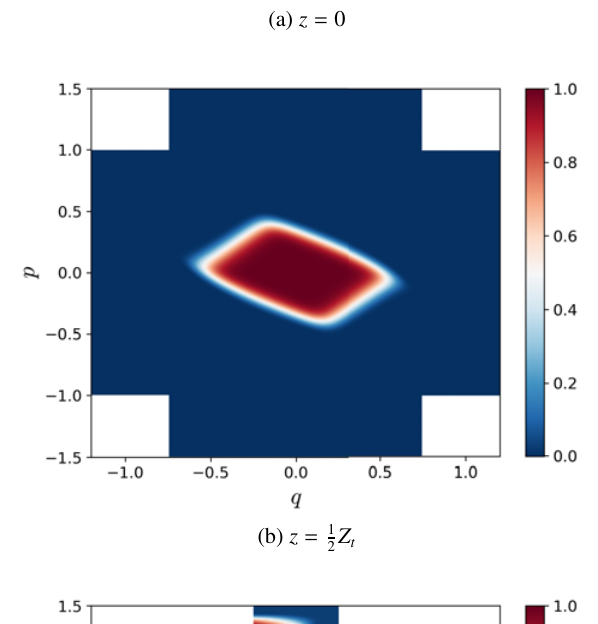
Figure 2: A DTIRC and a couple of light rays. The gray colour represents a refractive index n 1 = 1 . 5 and the white colour the background medium with n 0 =